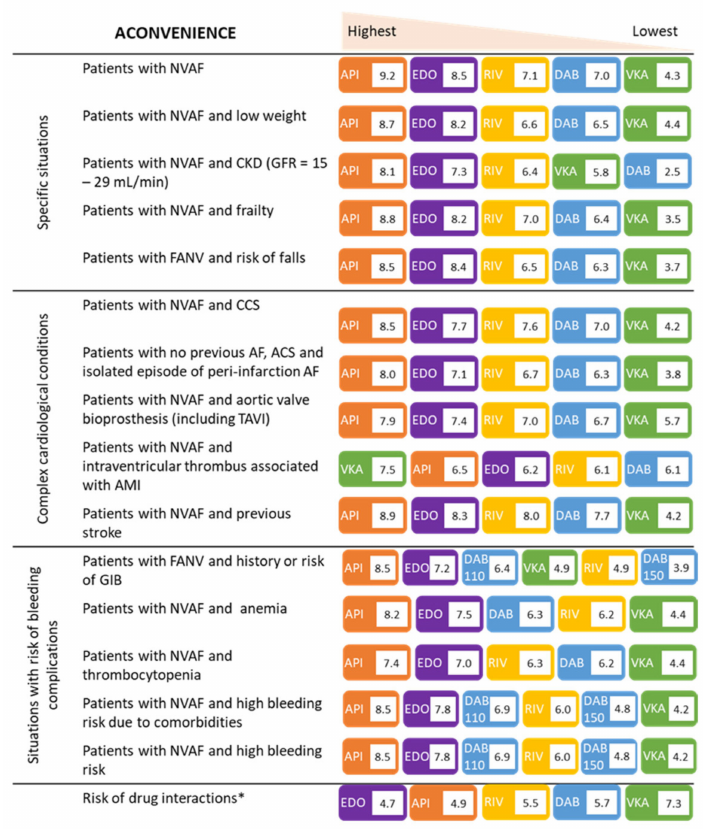
Figure 2. Mean score for available anticoagulation options in different clinical situations that may be encountered in elderly patients (maximum score = 10; minimum score = 1). ACS, acute coronary syndrome; AMI, acute myocardial infarction; API, apixaban; CCS, chronic coronary syndrome; CKD, chronic kidney disease; DAB, dabigatran; EDO, edoxaban; GFR, glomerular filtration rate; GIB, gastrointestinal bleeding; NVAF, non-valvular atrial fibrillation; RIV, rivaroxaban; TAVI, transcatheter aortic valve implantation; VKA, vitamin K antagonists. * The question was made on the OAC with less risk of drug